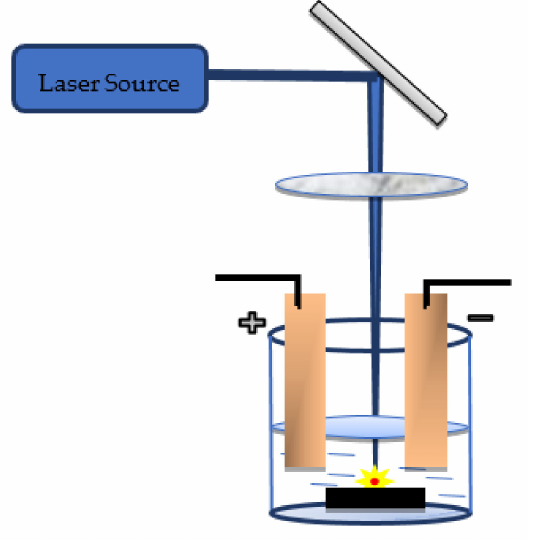
Figure 11. Illustration of electric field-assisted pulsed laser ablation of solid metal targets in liquid